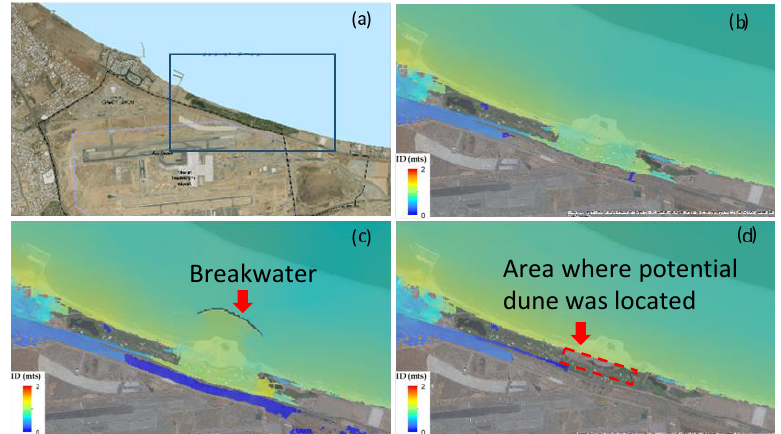
Figure 12. Detailed analysis of preliminary engineering RRM: (a) zoomed sample area, and (b) the modelled flooded area (c) with the breakwater option and (d) with the artificial sand dune